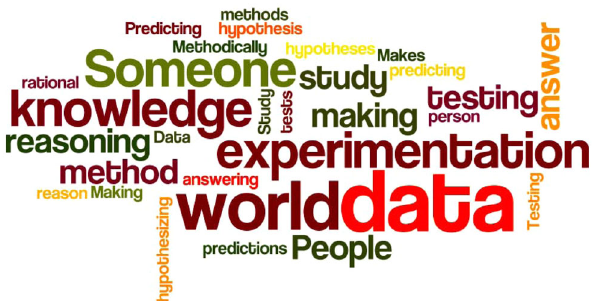
FIG. 3. Wordle created from student definitions of science and scientists, from the essay on their midterm